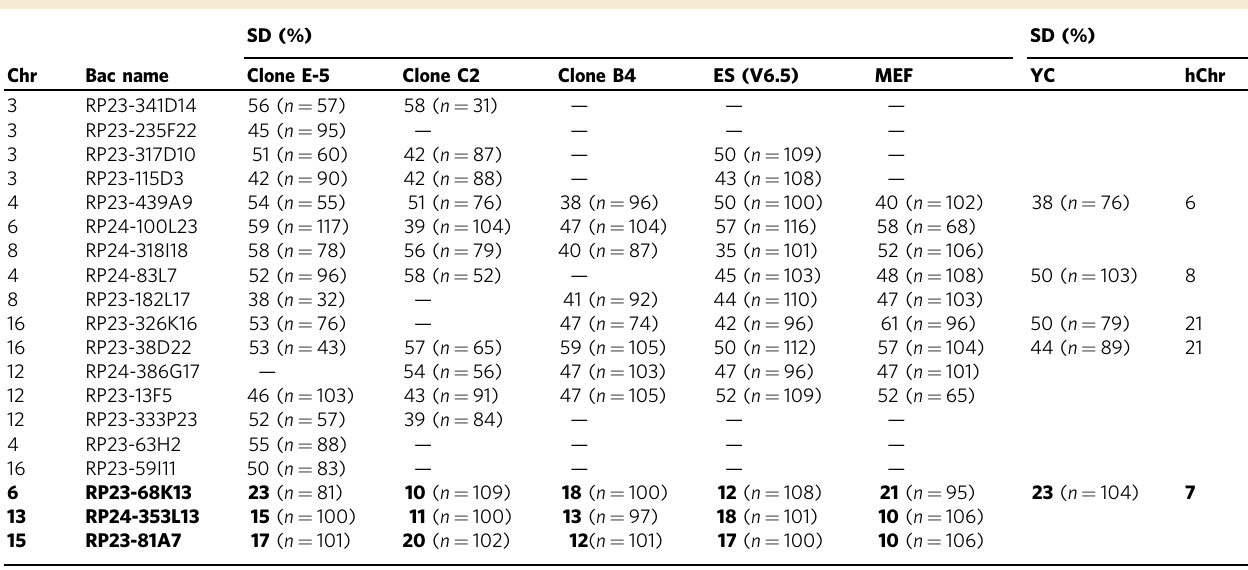
Table 1 Asynchronous replication timing by FISH